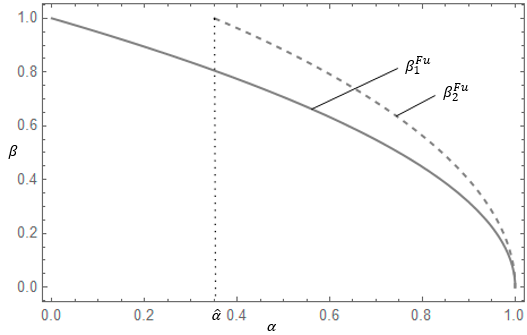
Figure 1. The changing trends of